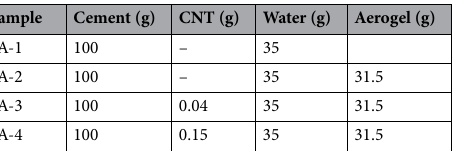
Table 5. Mixing composition of CNT-cement paste for the semi-adiabatic calorimetry test.